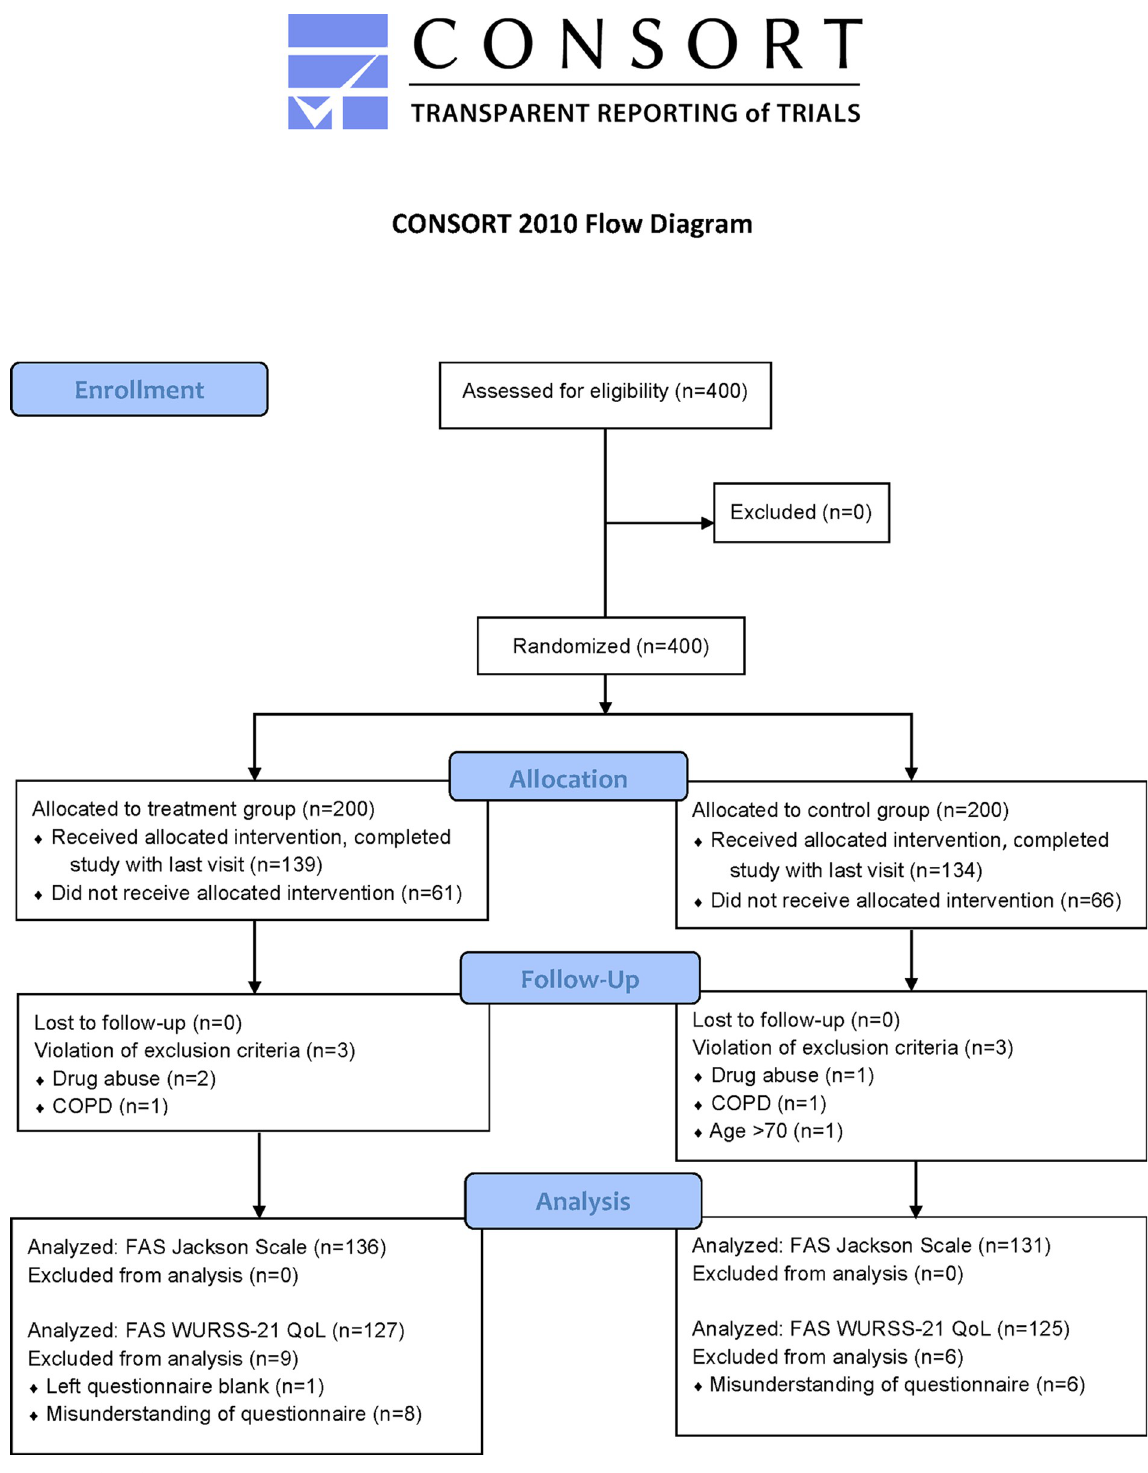
Fig 1. Trial profile.